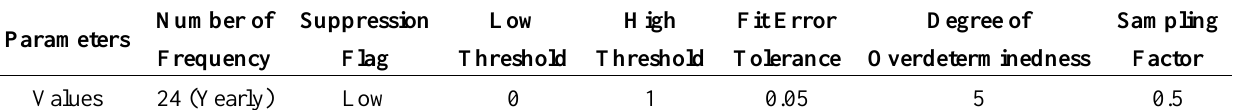
Table 1. HANTS parameter settings applied in this study.